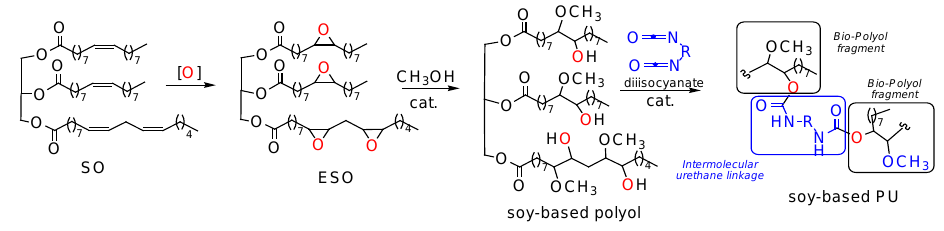
Figure 2. Scheme of general synthesis of soy-based PU.